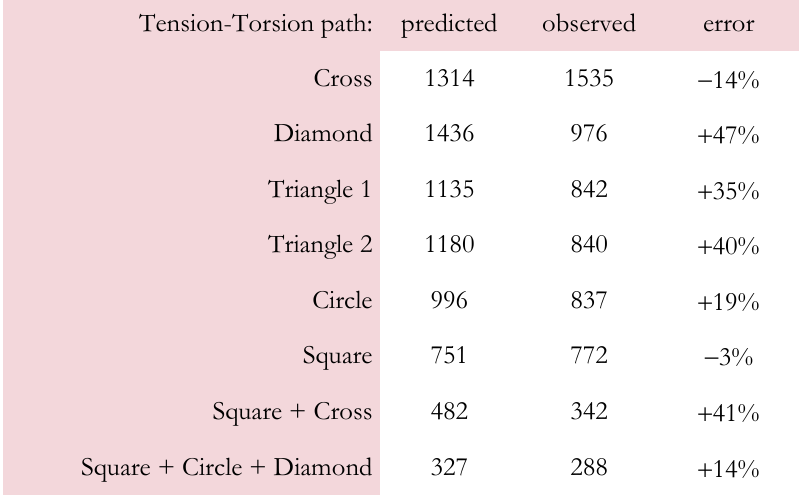
Table 1: Predicted and observed lives, in number of blocks, for each applied